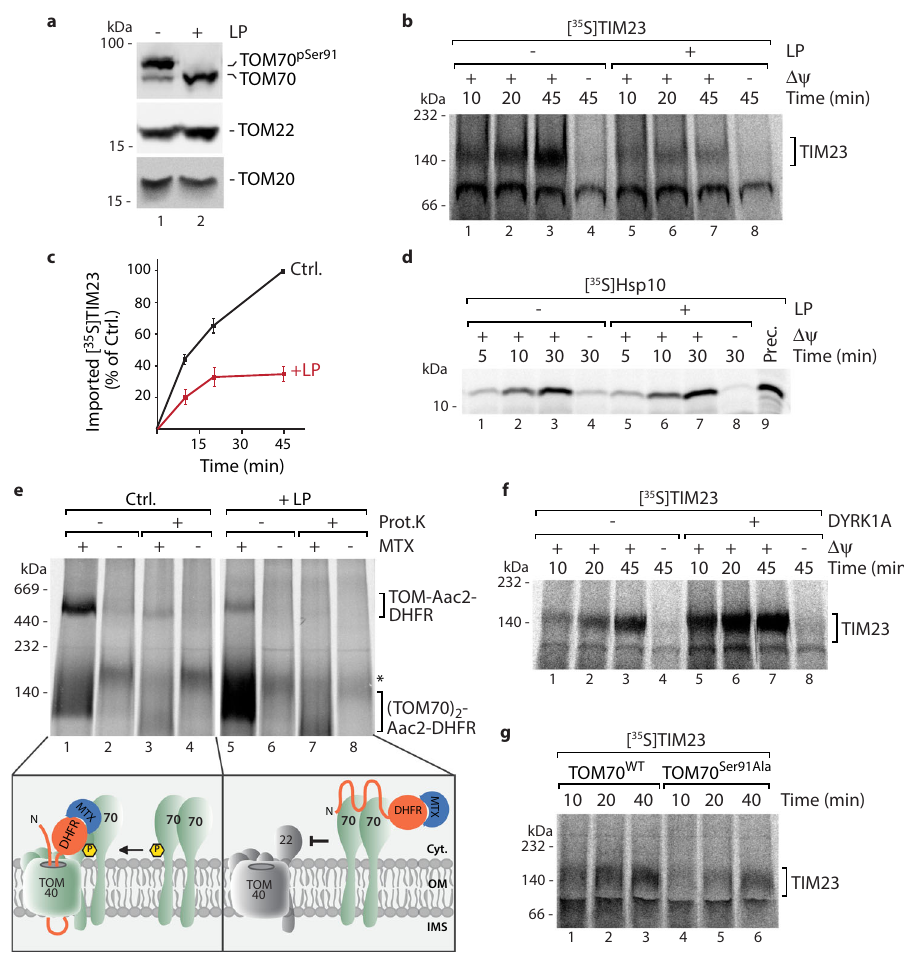
Fig. 5 TOM70 Ser91 phosphorylation by DYRK1A activates the metabolite carrier import pathway. a Phos-tag gel analysis of TOM import receptors in mitochondria upon treatment with lambda phosphatase (LP). b Import of radiolabelled TIM23 precursor into isolated mitochondria treated with ( + ) or without ( − ) lambda phosphatase (LP) as shown in a . Where indicated the membrane potential Δψ was dissipated prior to the import reaction. Samples were lysed in digitonin buffer and subjected to Blue Native PAGE. Imported protein was analyzed by autoradiography. c Quanti fi cation of imported TIM23 from b . Ctrl. at 45 min import time was set to 100%. Data represent mean ± SEM from three independent experiments. d Import of radiolabelled Hsp10 precursor (Prec.) into isolated mitochondria that were treated with ( + ) or without ( − ) lambda phosphatase (LP). Samples were treated with proteinase K after import and analyzed by SDS-PAGE and autoradiography. e Import of radiolabelled Aac2-DHFR precursor for 25 min into mitochondria that have been treated as in a – d in the presence or absence of Methotrexate (MTX). Samples were separated via Blue Native PAGE and analyzed by